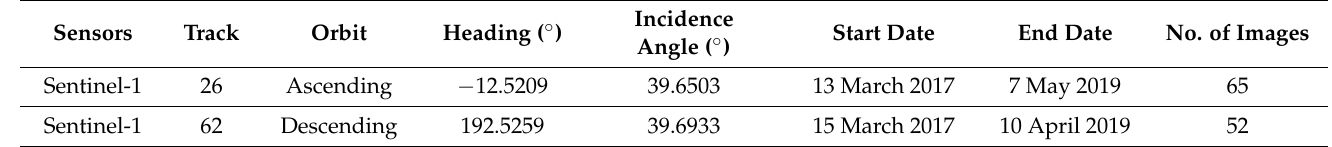
Table 1. Basic parameters of SAR images acquired for the study.